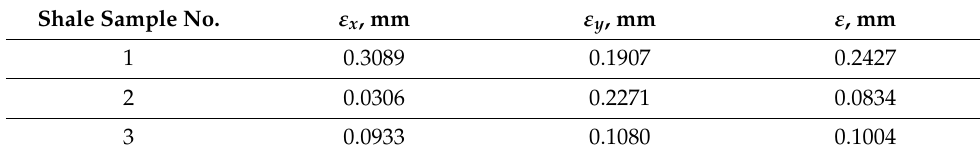
Table 1. Roughness of shale fracture surface morphology. Shale Sample